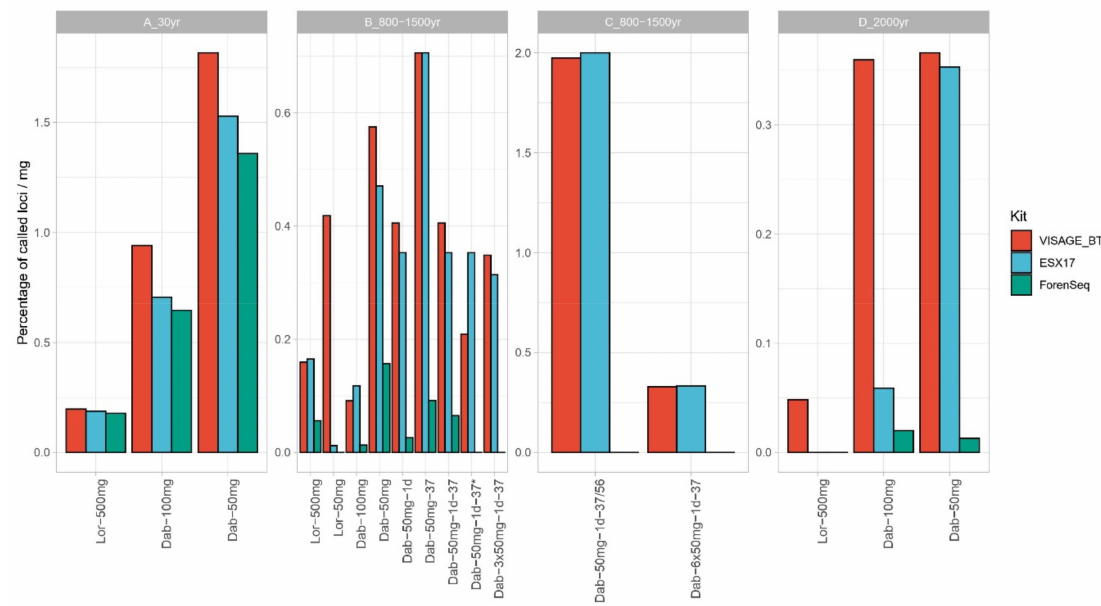
Figure 4. Percentage of called nuclear DNA loci per amount of bone powder input for all samples and extraction trials using VISAGE Basic Tool (153 SNPs in total), ESX 17 (17 STRs in total), and ForenSeq (94 SNPs and 58 STRs). Samples Lor-50 mg, Dab-50 mg-1d-37 *, Dab-3 × 50 mg-1d-37, Dab-50 mg-1d-37/56, and Dab-6 × 50 mg-1d-37 were not typed using the ForenSeq panel because this analysis was performed before these extraction